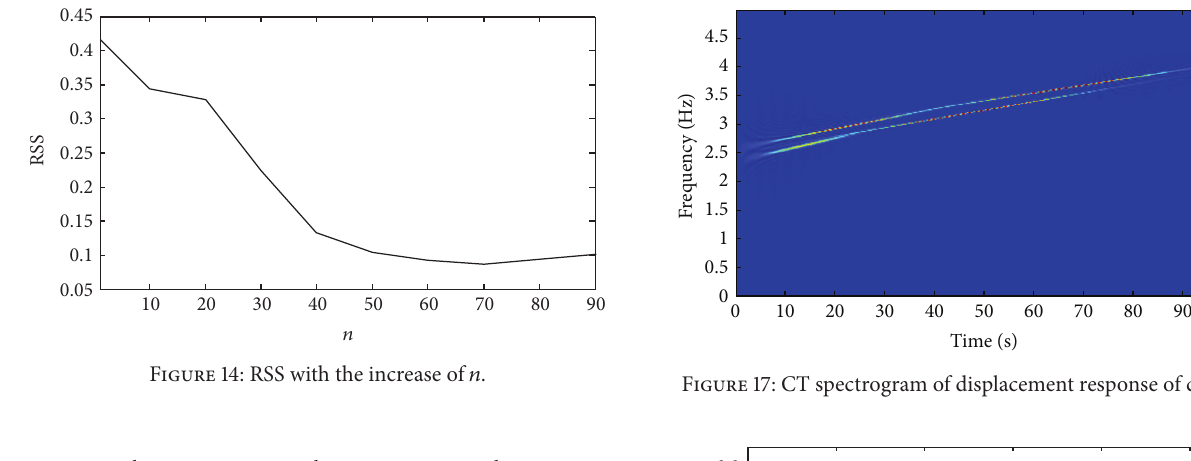
Figure 17: CT spectrogram of displacement response of case 3.